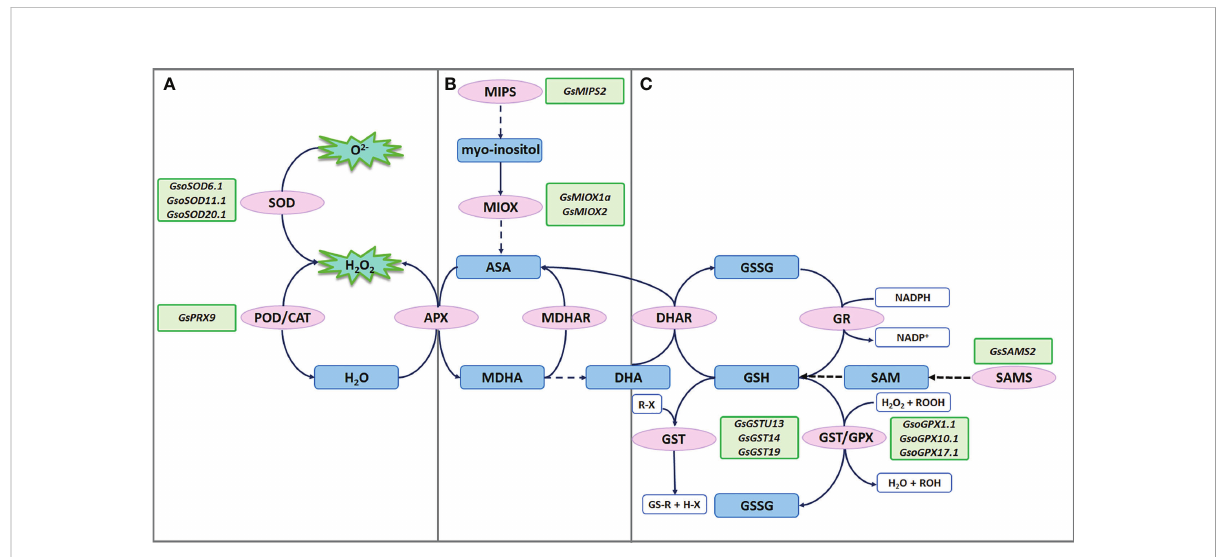
FIGURE 2 ROS scavenging under salt-alkaline stress in wild soybean. (A) SODs and PRXs in enzymatic antioxidant defense system. (B) MIPSs and MIOXs responsible for AsA biosynthesis. (C) GSTs, GPXs and SAMSs responsible for glutathione mediated nonenzymatic antioxidant defense system.